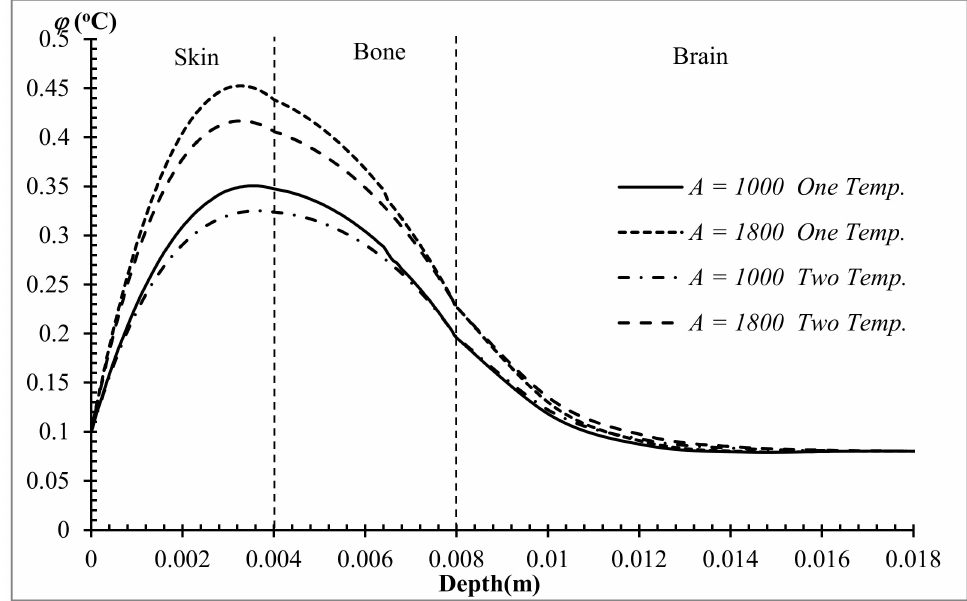
Figure 4. The conductive temperature increment with the various frequency on an adult’s head.